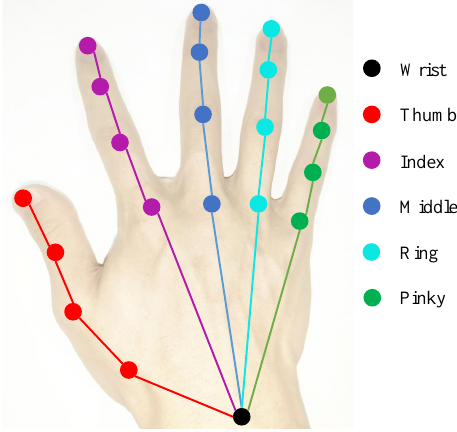
Figure 1. The illustration of hand model with 21 joints.